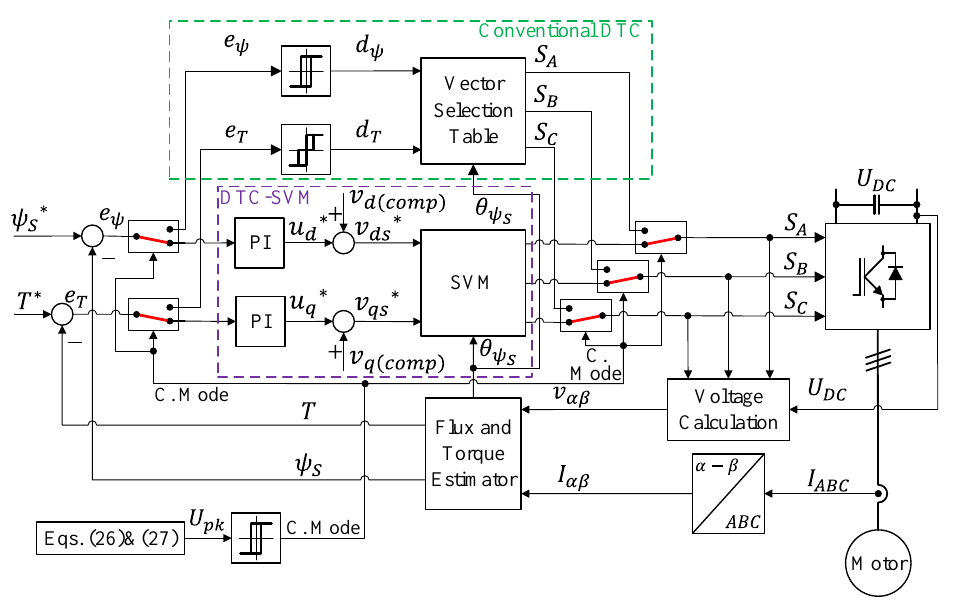
Figure 12. DTC – SVM combined with conventional DTC. Figure 12. DTC–SVM combined with conventional